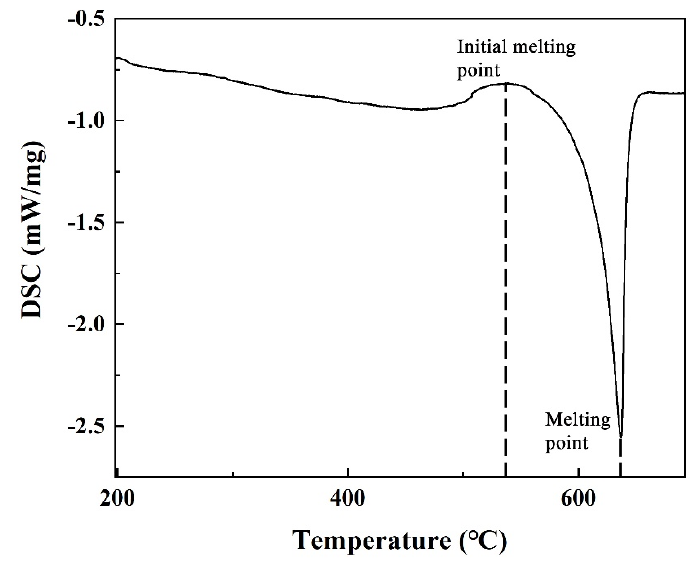
Figure 1. Differential scanning calorimetry (DSC) curve of the alloys.